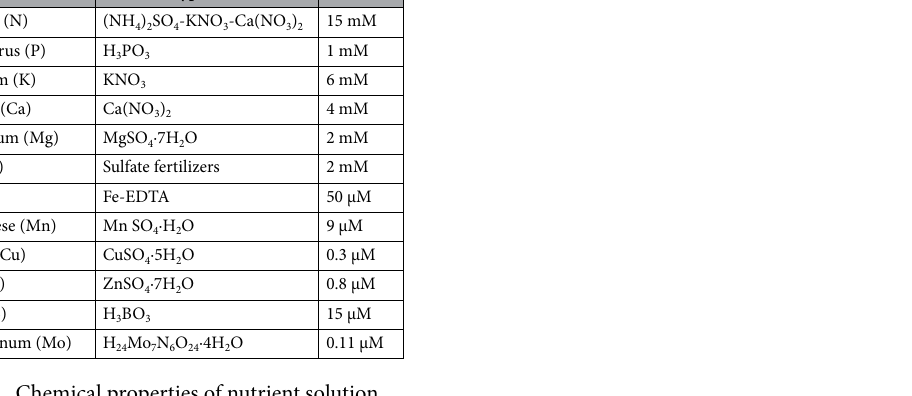
Table 1. Chemical properties of nutrient